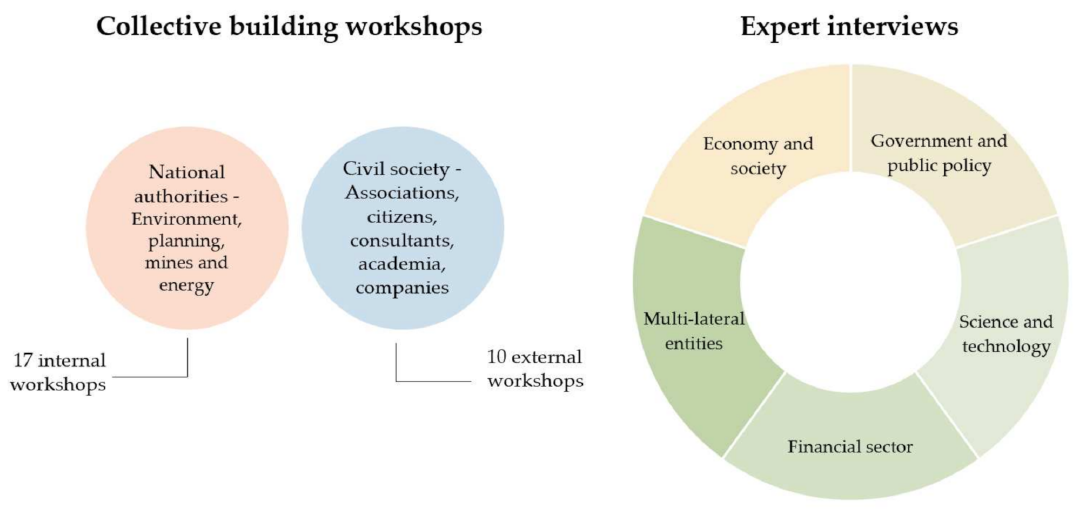
Figure 2. Colombia’s scenario development participatory workshops for the national energy plan 2020–2050 carried out by Energy and Mining Planning Unit [67].